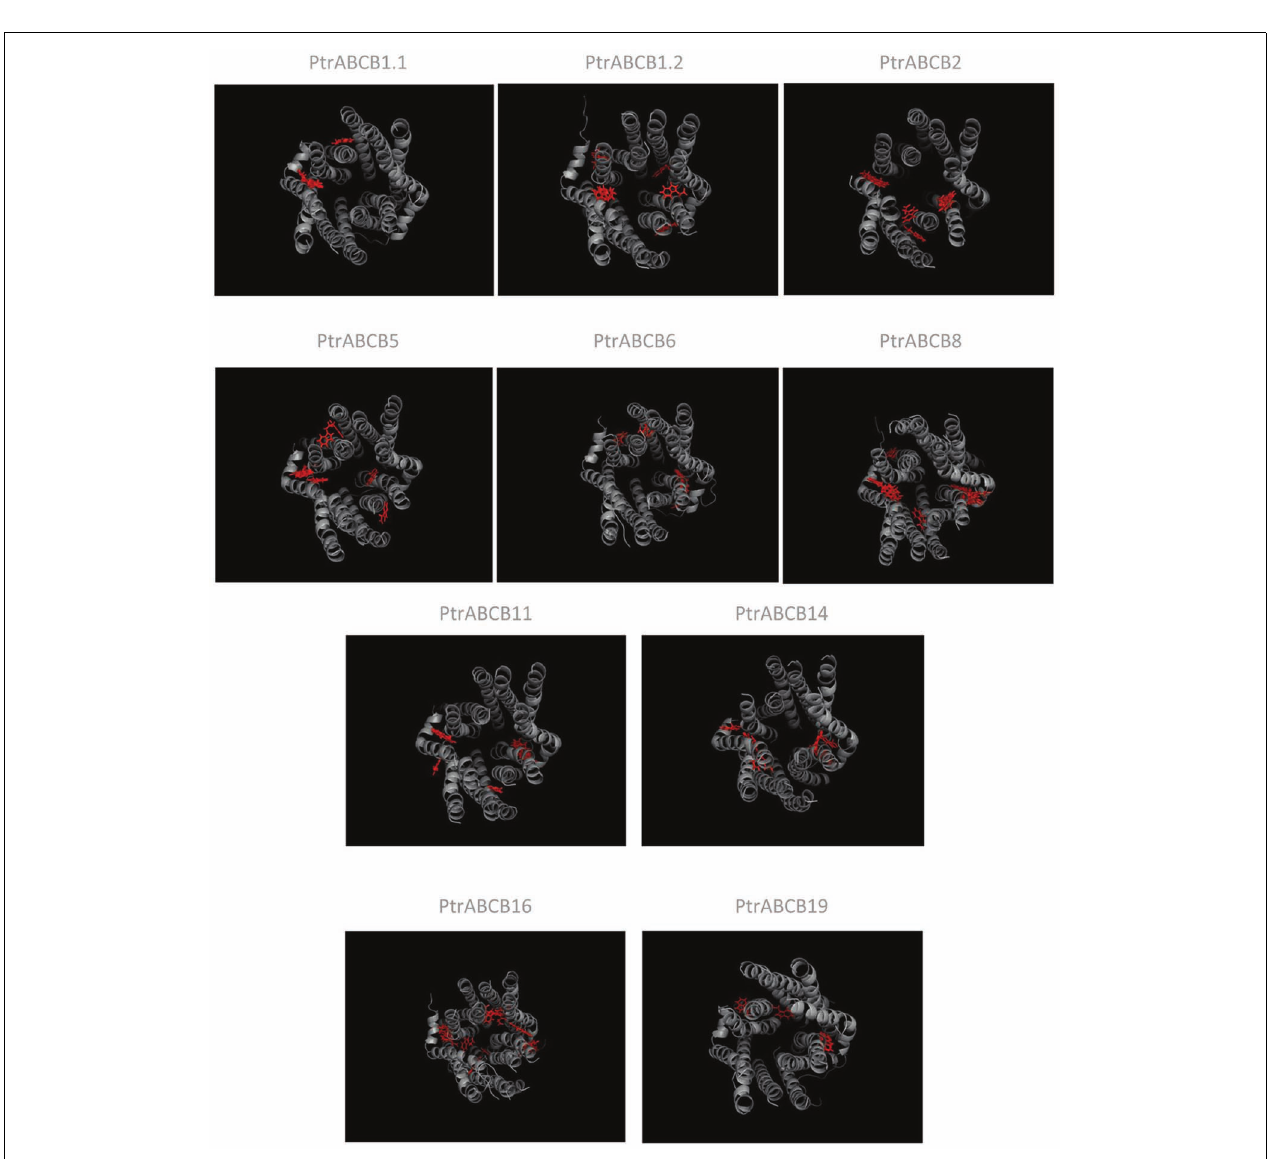
FIGUREA2 | Predicted model structures of putative auxin transportABCBs from Populus trichocarpa. Tertiary protein structures have been generated using the python script Modeller 9v5. Predicted IAA docking sites are depicted in red.